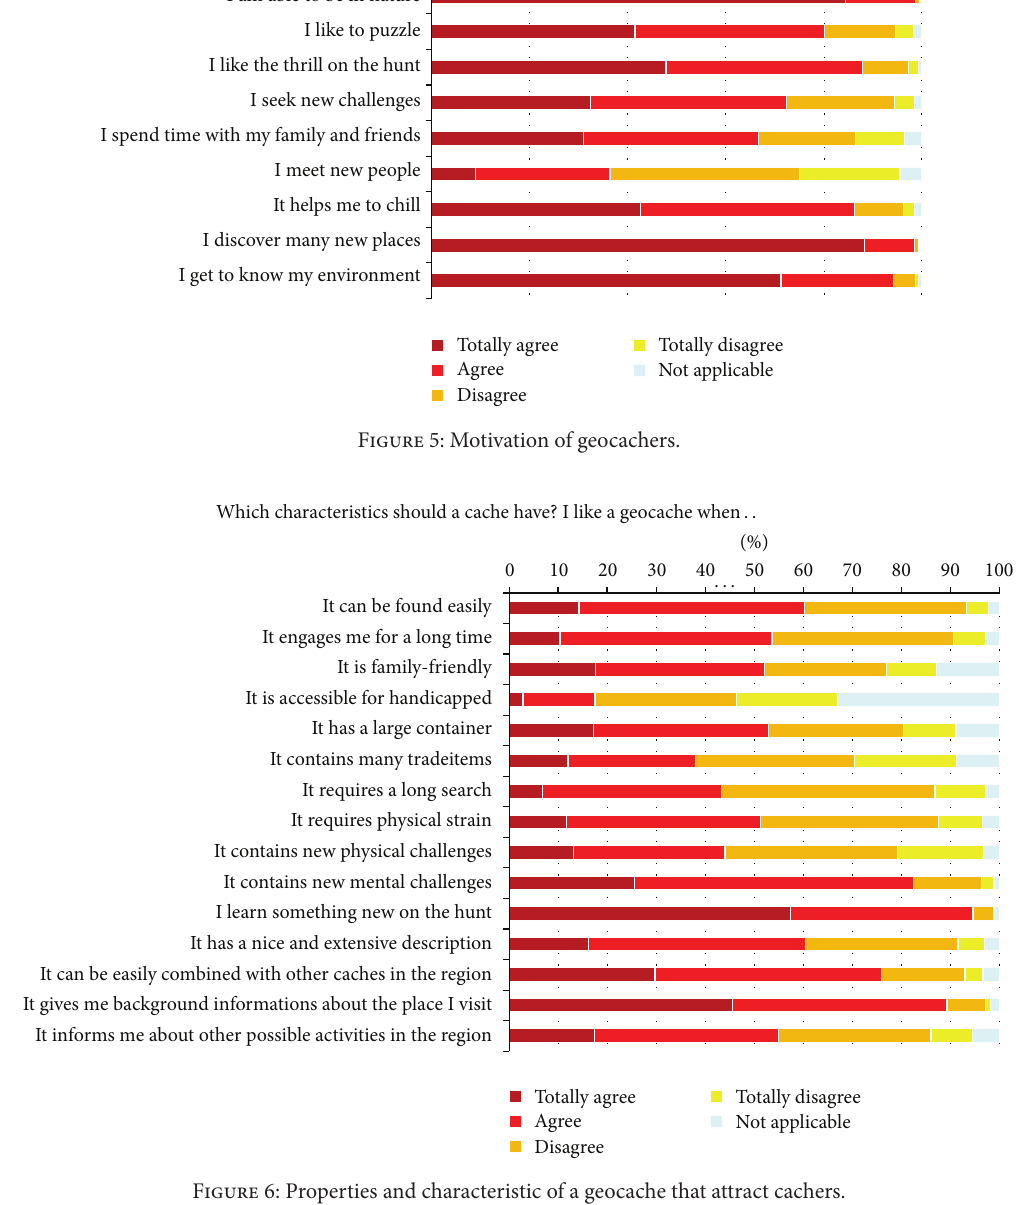
Figure 6: Properties and characteristic of a geocache that attract